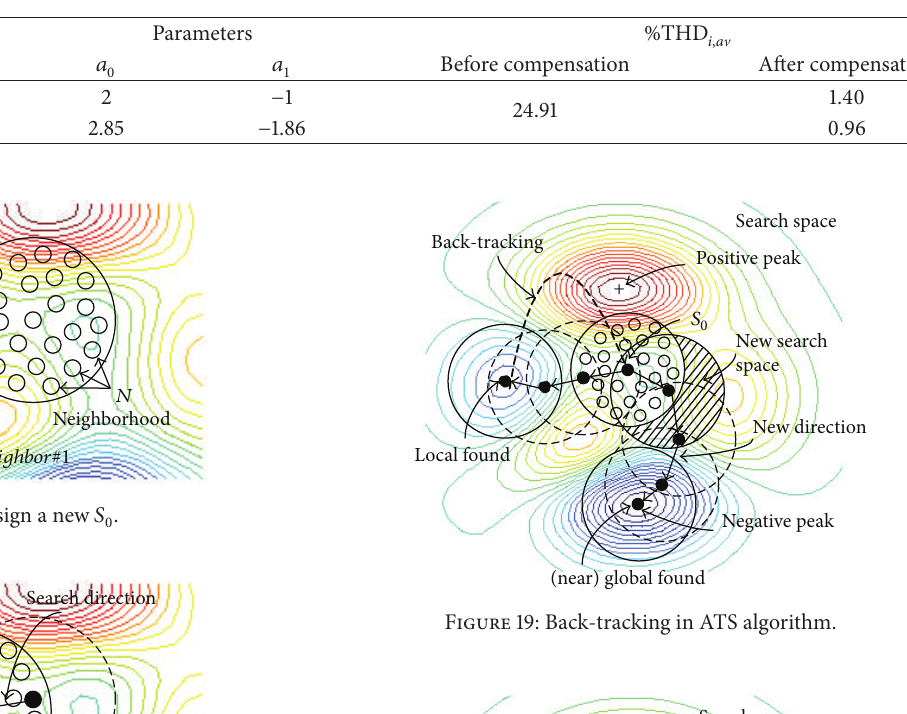
Table 4: The simulation results.